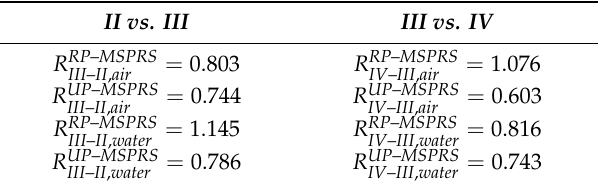
Table 4. Resolution of adjacent MSPRS resonances for RP-MSPRS and UP-MSPRS in air and water. II vs. III III vs.